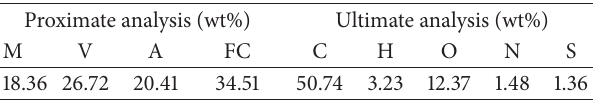
Table 1: Results of proximate and ultimate analyses of the dried lignite specimen.